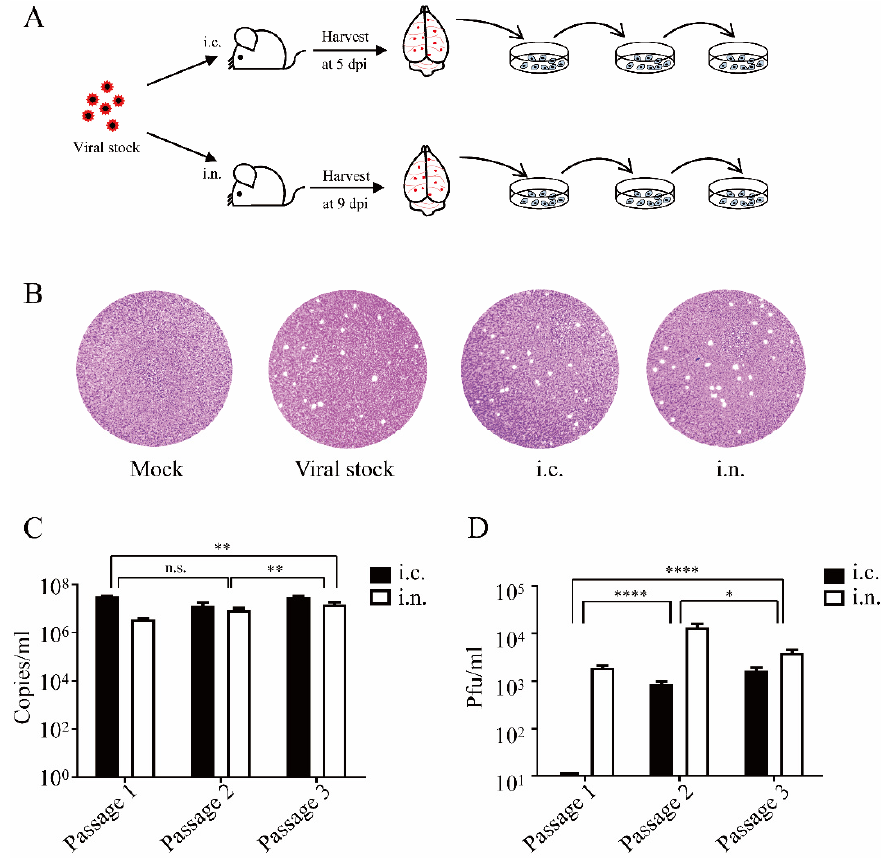
Figure 4. Isolation of DENV-2 from Vero cells. ( A ) Experimental scheme. Three days old BALB/c suckling mice were intracranially or intranasally challenged with DENV-2. The brain tissues were harvested at 5 or 9 dpi. Isolates were passage cultured for three generations. ( B ) Plaque morphology of DENV-2 viral origin and isolates from intracranially or intranasally infected mouse. ( C ) DENV-2 was isolated from Vero cells and cultured for three passages; viral loads were evaluated by RT-qPCR. ( D ) The viral titer of each passage was evaluated in Vero cells. Abbreviations: i.c., intracranial; i.n., in- tranasal; PFU, plaque forming unit. Histograms: mean ± S.D. Two-way ANOVA test; ****, p < 0.0001; **, p < 0.01; *, p < 0.05; ns, not